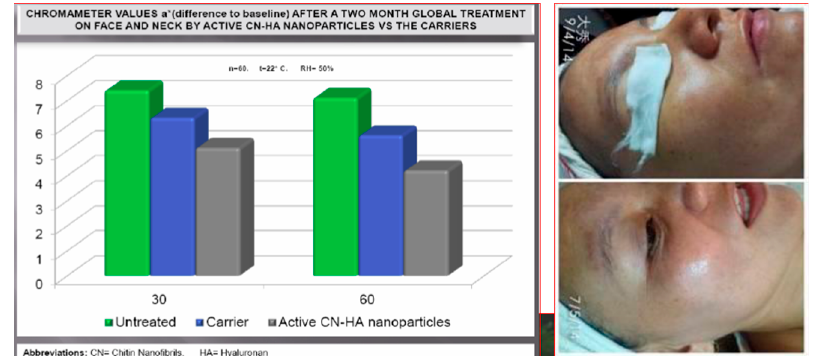
Figure 15. Whitening activity of chitin nanofibril–lignin entrapping active ingredients [76].